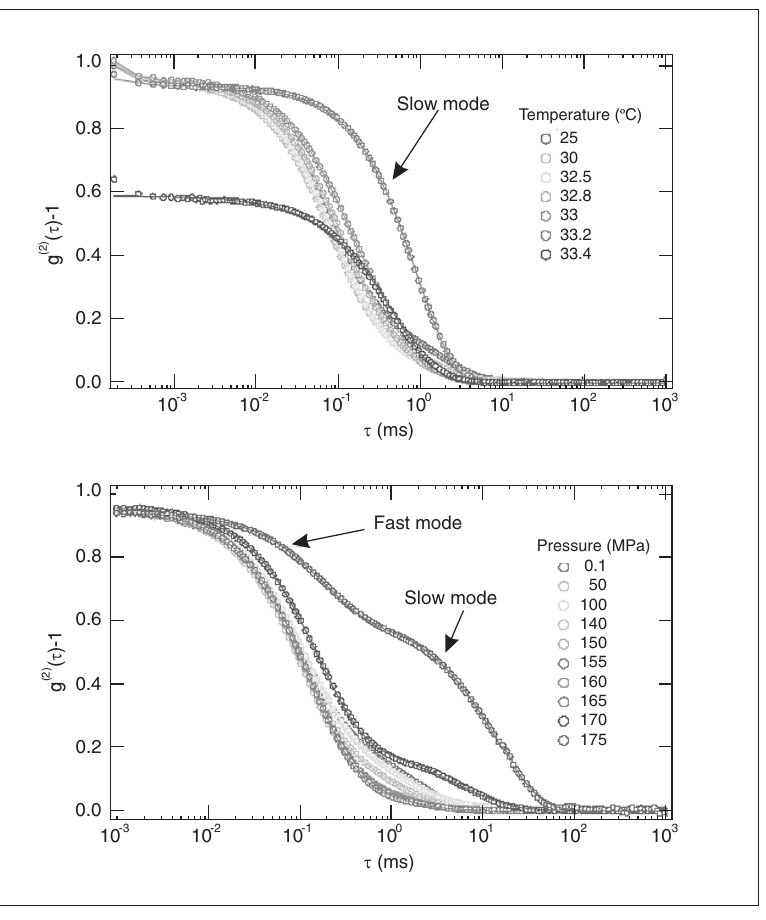
Figure 3. Changes in the stretched exponent (ß), the ratio of fast mode (A), the diffusion constant (D f ) and the relaxation time of the slow mode (< τ s >) cal- culated from the data shown in Figure 2, during the temperature change at 0.1 MPa (upper ar- ray) and during the pressure changes at 25 º C (lower